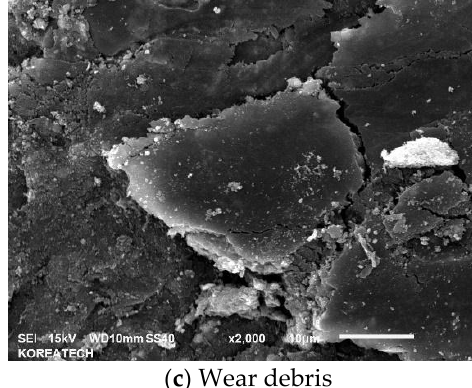
Figure 7. SEM images of wear tracks of the C/C-SiC composite showing the cracks on the surface. Materials 2017 , 10 , 701